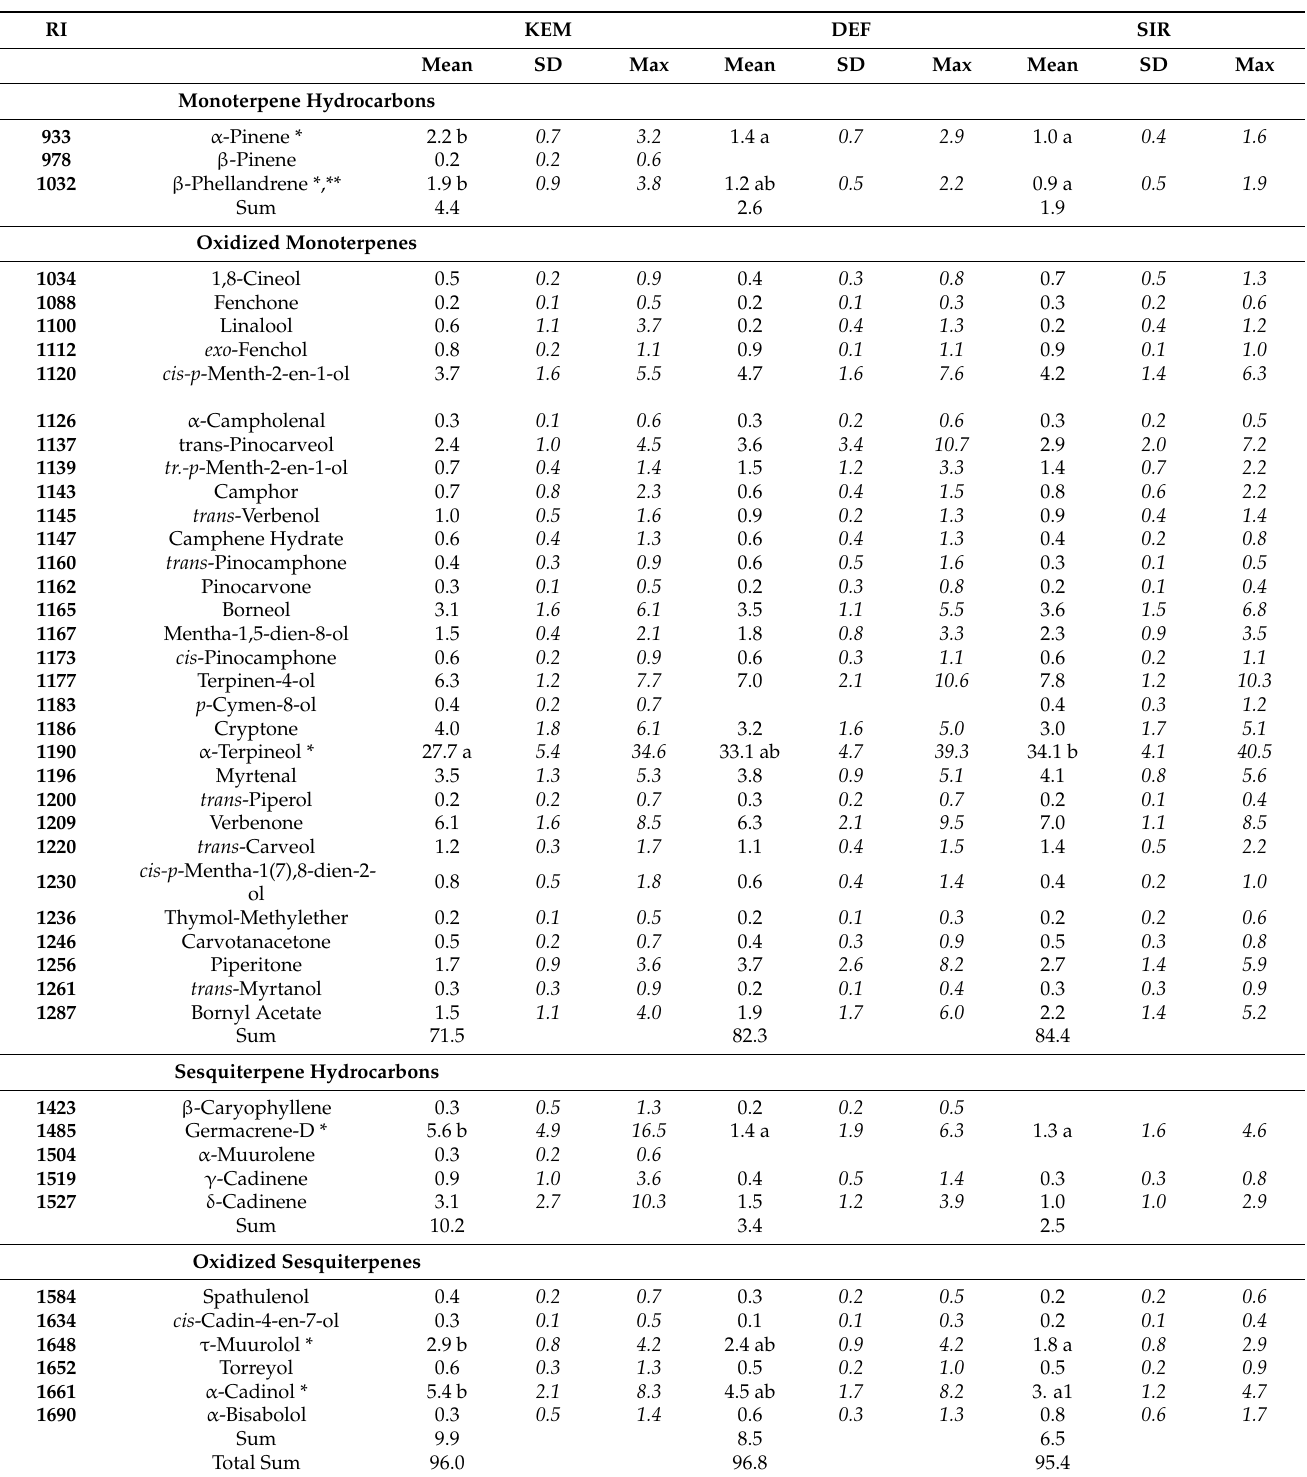
Table 2. Composition of the hydrolate volatiles (%) from Pinus cembra